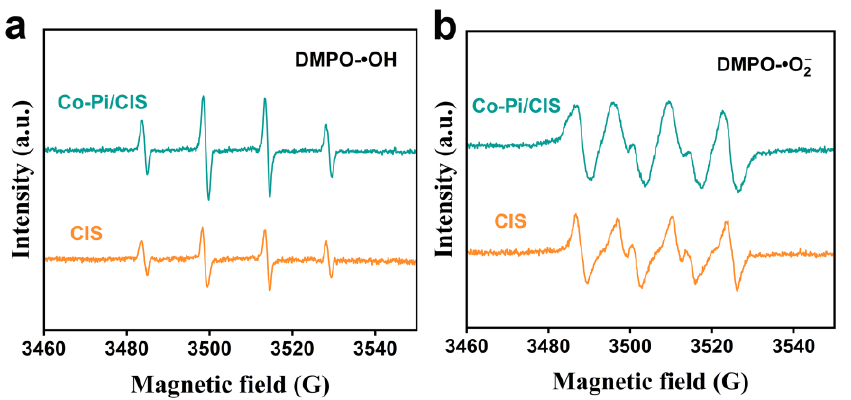
Figure 5. Electron paramagnetic resonance (EPR) spectra of ( a ) hydroxyl radicals ( • OH) and ( b ) superoxide radicals (• O 2_ ) trapped by 5,5-Dimethyl-1-pyrroline-N-oxide (DMPO) in the CIS and Co-Pi/CIS dispersion solution.